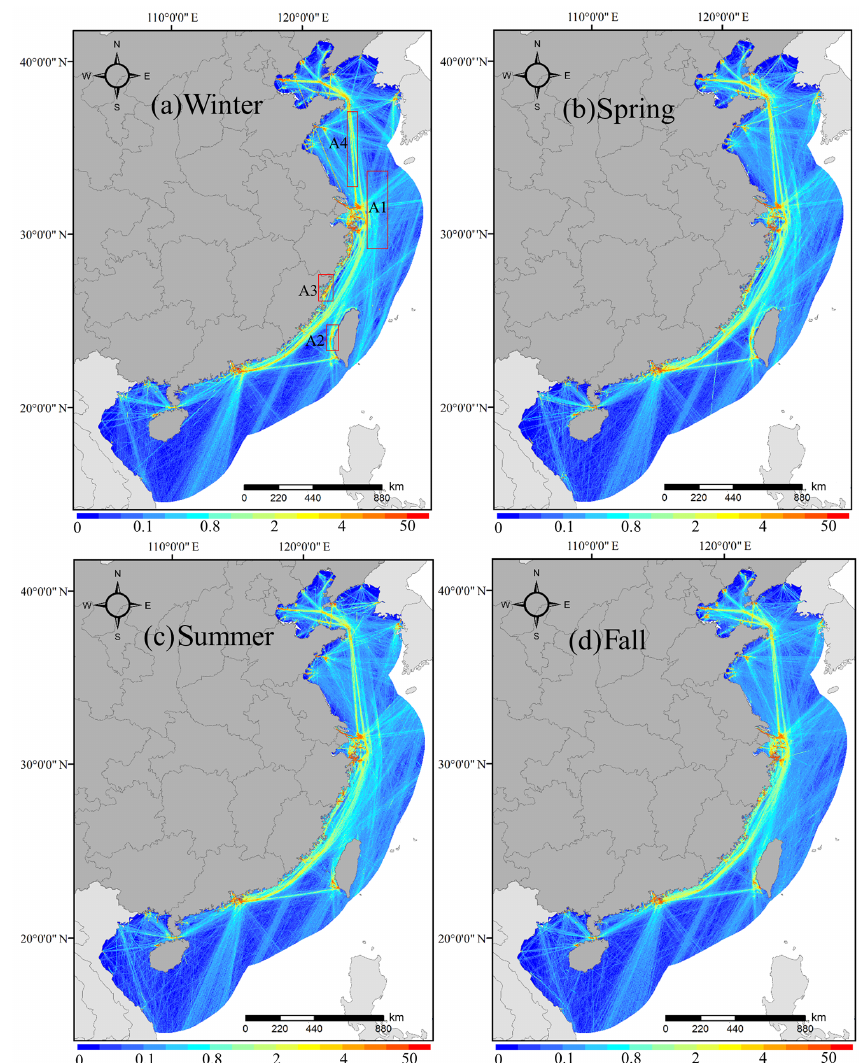
Figure 2. Spatial distributions of SO 2 emissions from ships at a resolution of 3km × 3km (unit, tonnes per grid) in (a) winter, (b) spring, (c) summer and (d)